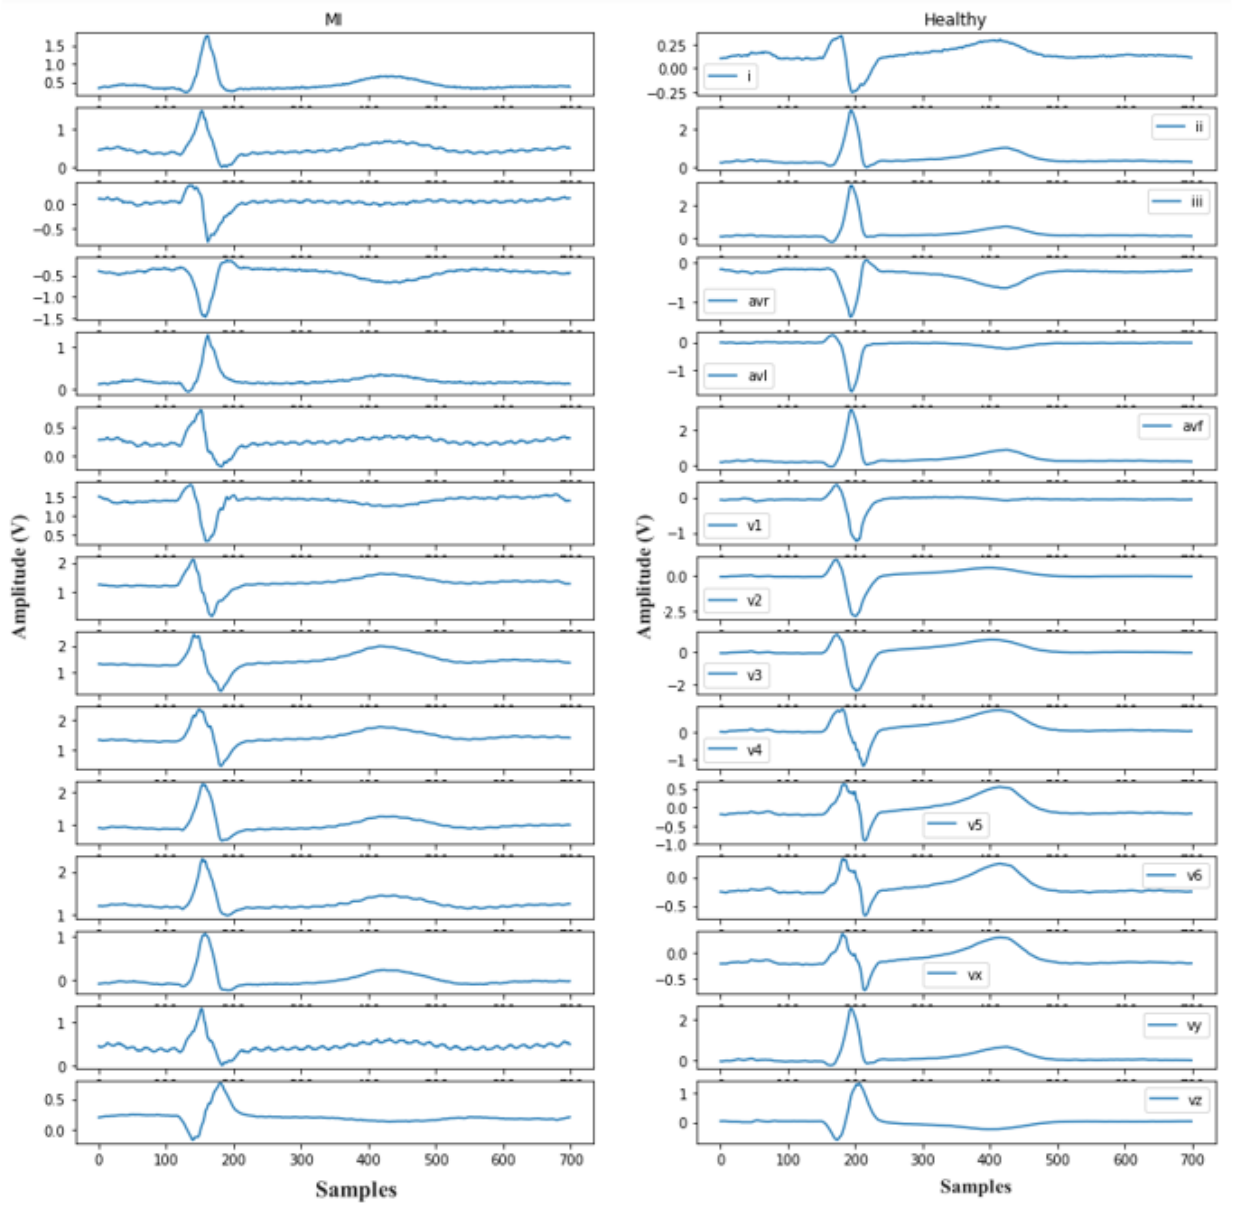
Figure 2. 15 lead ECG signal for MI and Normal/Healthy class. The number of beats for the normal class was 18.78% (126,347 beats) out of a total of 672,907 beats. Among MI classes, the highest and lowest number of beats were in the inferior (140.813 beats, 20.93%) and inferior posterior (547 beats, 0.09%). For all leads, the highest and lowest total beats are in lead v2 and lead avf which are 50,333 and 33,674, respectively. Figure 2 shows a segment of the 15 lead ECG signals from the Normal and MI classes. Each ECG signal from each lead exhibits different characteristics as it represents vector information from position sensors placed in different geographic locations of the chest. An example of reading the lead v2 signal waveform for various MI classes and healthy classes is depicted in Figure